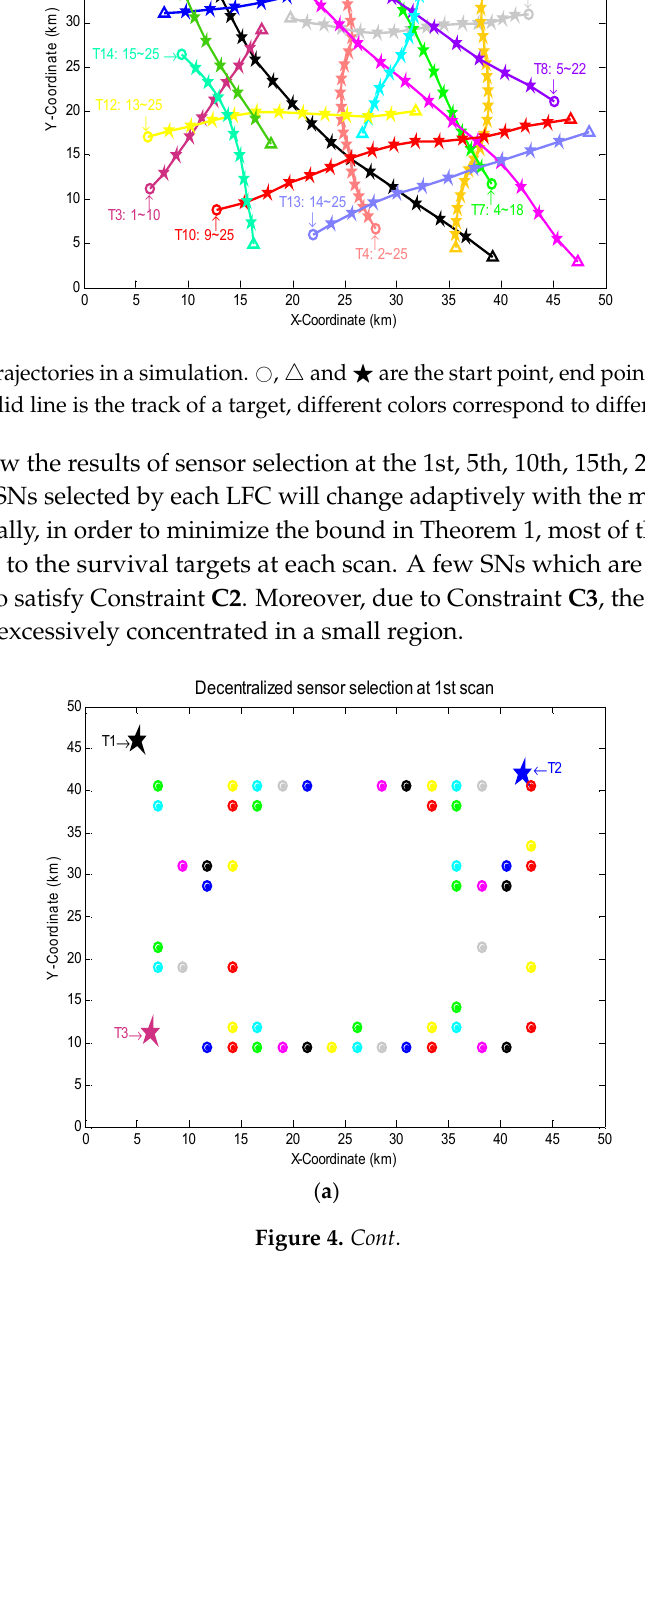
targets at the 15th~18th scans is the most (13 targets). The target T1 intersects with the target T10 at the 15th scan.